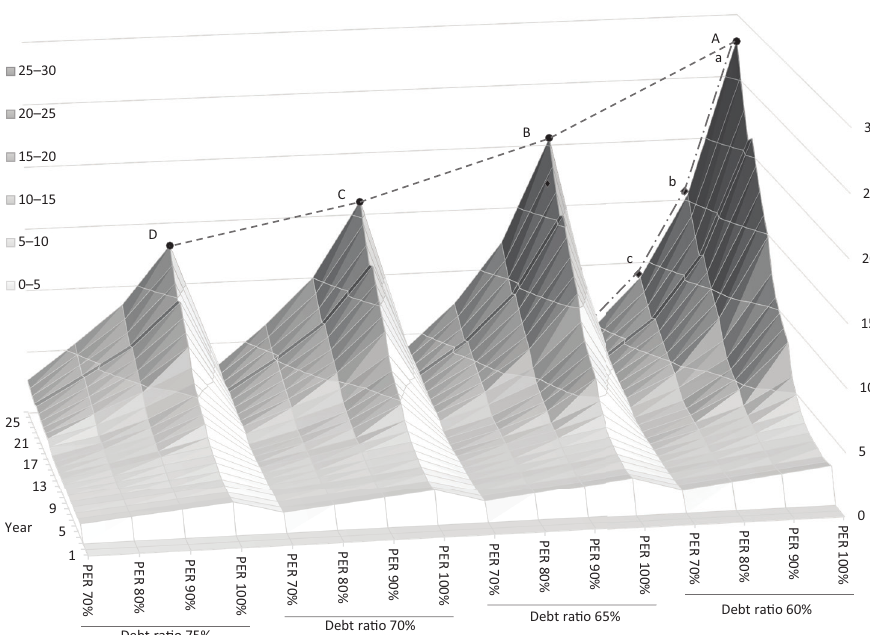
Figure 8. Simulation results for DSCR influenced by different financing strategies